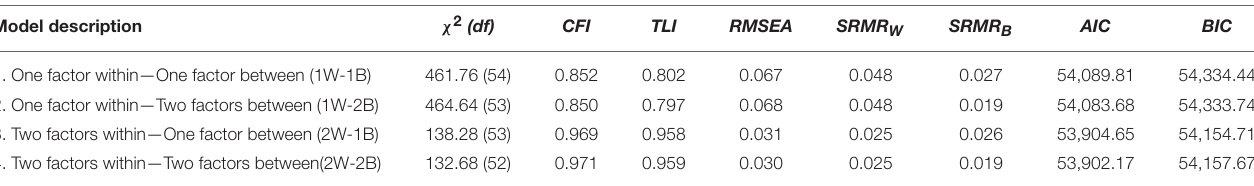
TABLE 3 | Model fit for the tested multilevel